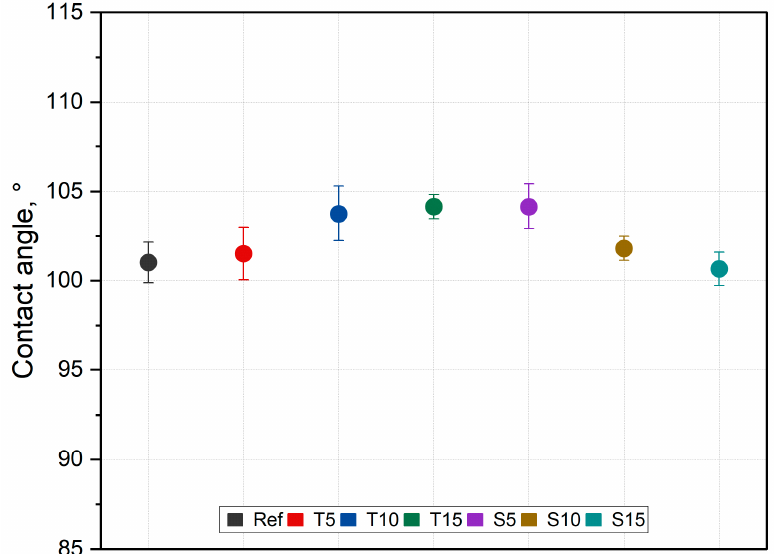
Figure 8. Contact angle results.